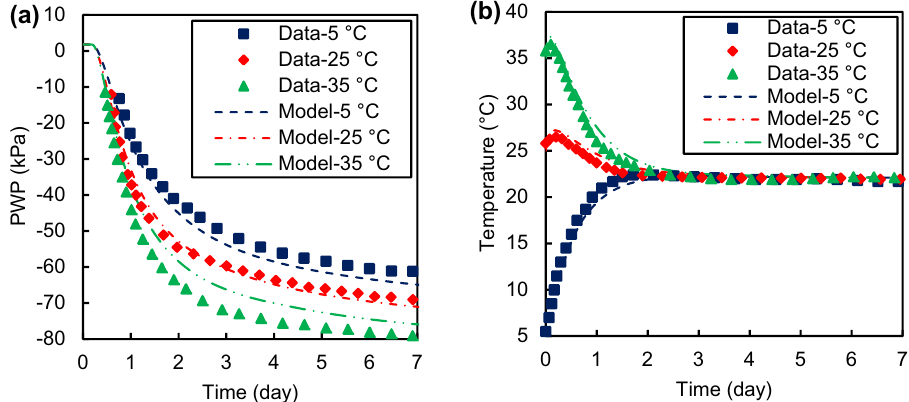
Fig. 9 Comparison of predicted results and experimental values: a PWP and b